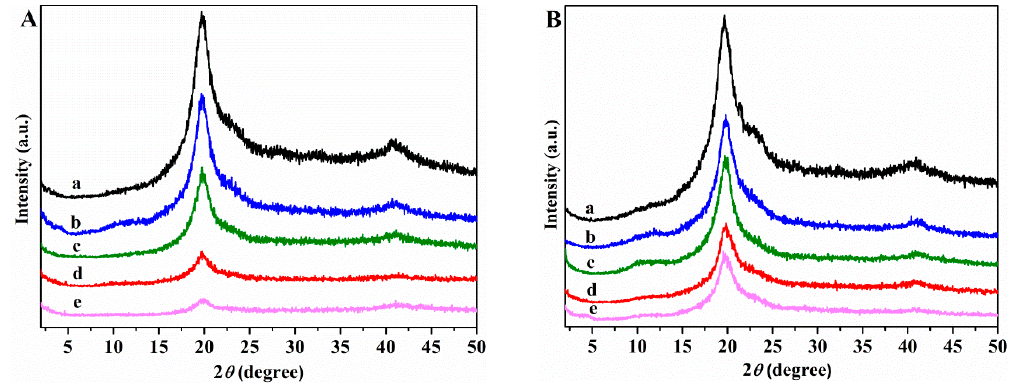
Figure 3. XRD patterns ( A ) (a) PVA; (b) PVA/GS0.5; (c) PVA/GS1; (d) PVA/GS1.5; (e) PVA/GS2; ( B ) (a) PVA/GLY; (b) PVA/GS0.5/GLY; (c) PVA/GS1/GLY; (d) PVA/GS1.5/GLY; and (e) PVA/GS2/GLY.